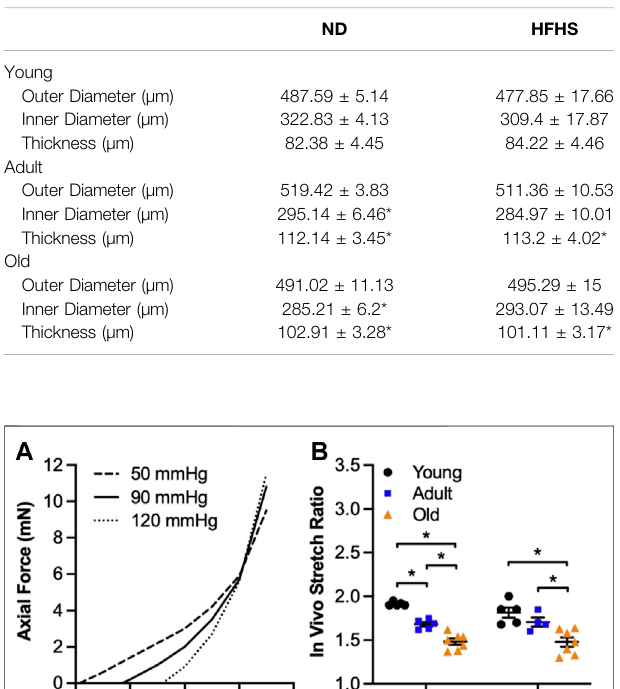
TABLE 1 | The arterial dimensions of CCA (mean ± SEM) in the unloaded con fi guration for the diet (ND and HFHS) and age (young, adult and old) groups (* p < 0.05 represents comparisons with the young group).